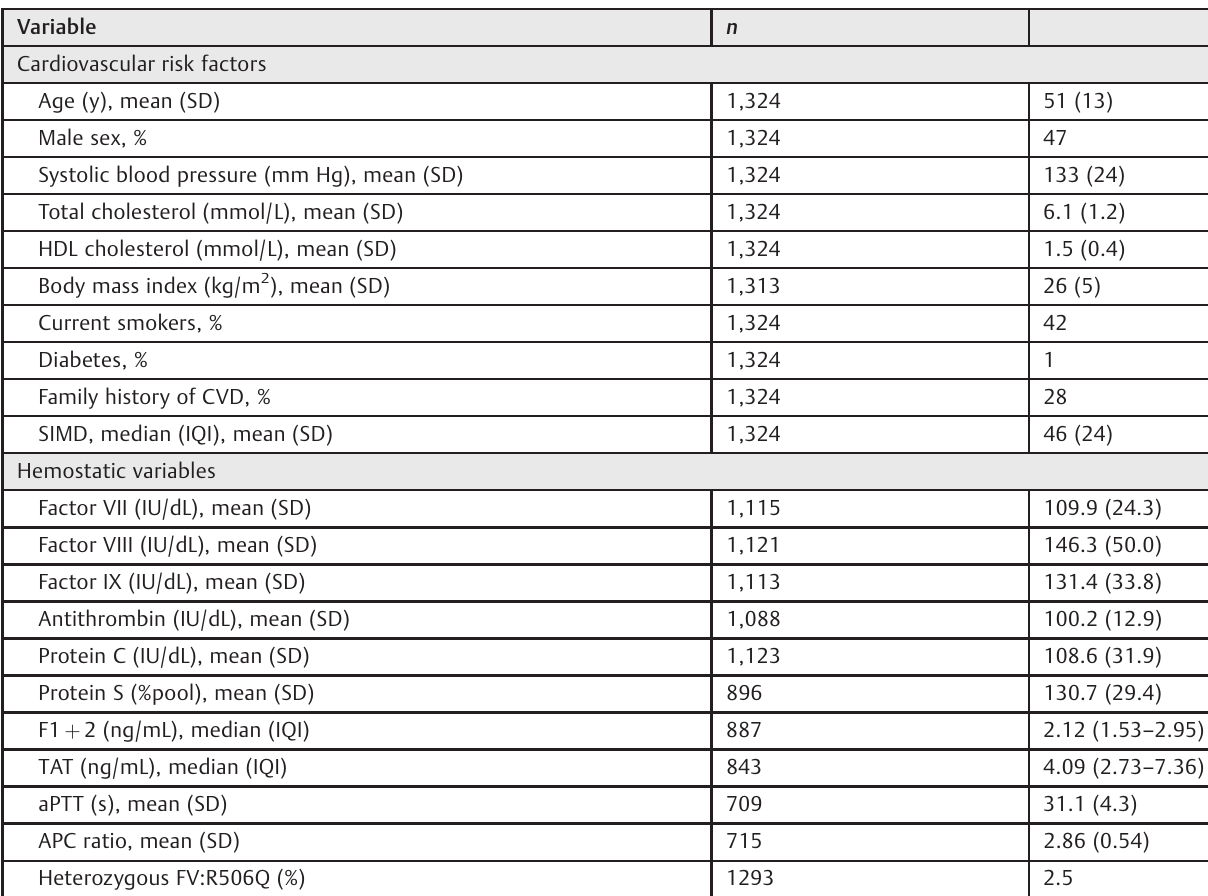
Table 3 Baseline summary statistics: 1992 MONICA